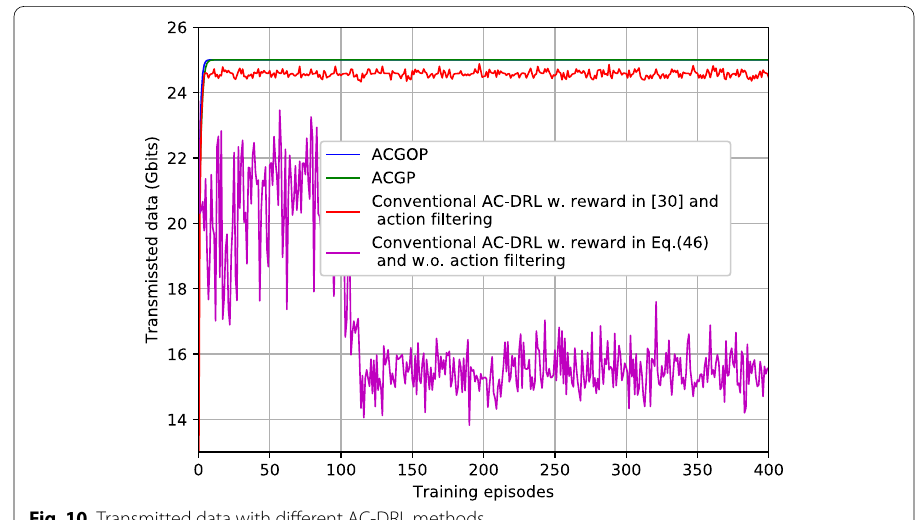
Fig. 10 Transmitted data with different AC-DRL methods